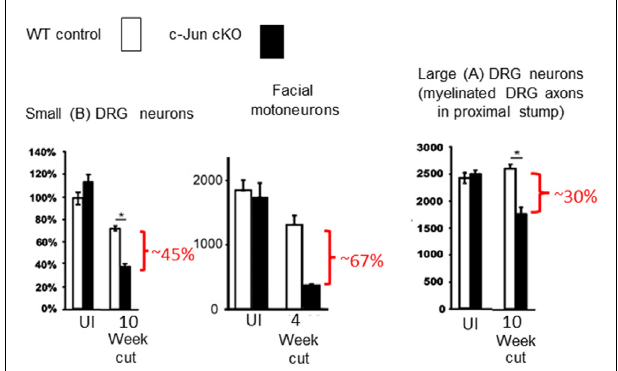
FIGURE 5 | Death of injured neurons without Schwann cell c-Jun. In the absence c-Jun activation in Schwann cells, nerve transection causes extensive death of large and small DRG neurons and facial motor neurons (modified from Arthur-Farraj et al.,